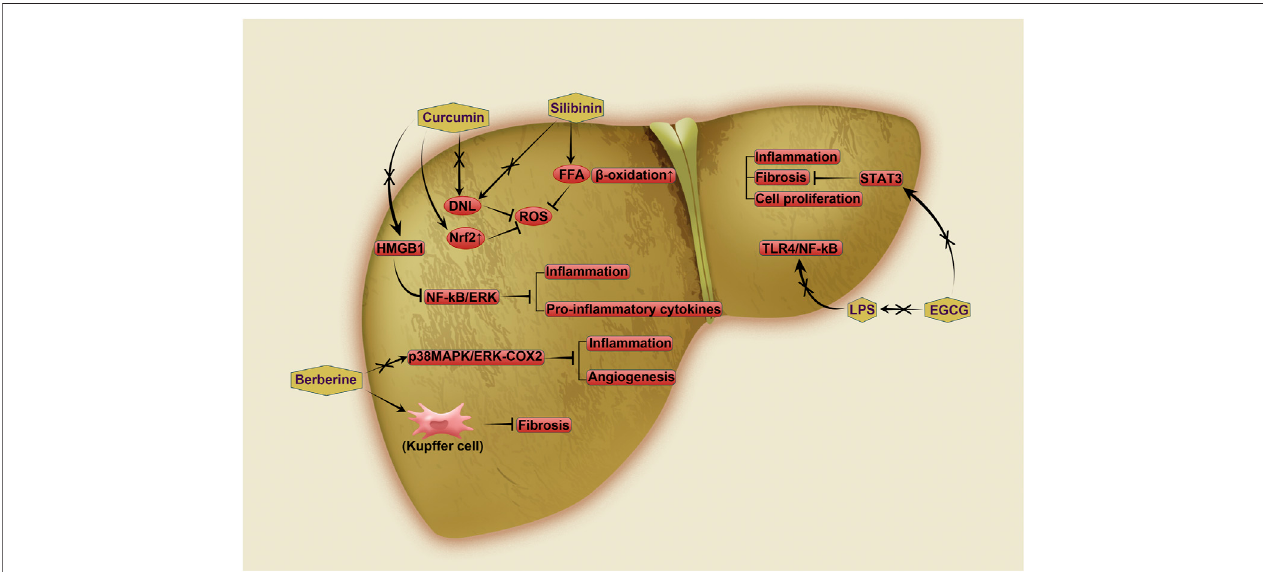
FIGURE 2 | Mechanisms of inhibition of NASH-driven HCC by four natural products. Curcumin can reduce the expression of HMGB1. This can in turn reduce in fl ammation and the production ofproin fl ammatoryfactorsby inhibiting both theNF-kB and ERK pathways, thereby inhibiting the developmentof HCC. Curcumin also inhibits NASH and NASH-HCC by downregulating DNL and upregulating Nrf2 expression, respectively,thereby suppressingROSproduction. Silibininalso inhibits DNL and, importantly, enhances β -oxidation of FFAs,thereby reducing ROS production. Berberine directly attenuates ROSproduction and hinders the developmentof HCC by upregulating p38MAPK/ERK-COX2. Thus, it reduces in fl ammation and inhibits hepatocyte apoptosis. EGCG regulates the development of NASH-HCC in two ways.First, itinhibits theprogressionofNASH toHCC byreducingthelevel ofLPSintheblood, therebyinhibiting theTLR4/NF-kB pathway. Additionally, itinhibitsHCC development by reducing STAT3 expression and suppressing in fl ammation, fi brosis and cell proliferation. HMGB1: high-mobility group box 1, Nf-kB: nuclear factor-jB kinase-b,ERK:extracellularsignal-regulatedkinase,HCC:hepatocellularcarcinoma,NASH:nonalcoholicsteatohepatitis,DNL: denovo lipogenesis,Nrf2:nuclearfactor erythroid 2-related 2, ROS: reactive oxygen species, MAPK: mitogen-activated protein kinase, COX2: cyclooxygenase2, EGCG: epigallocatechin gallate,TLR4: toll-like receptor 4, STAT3: signal transducer and activator of transcription 3.